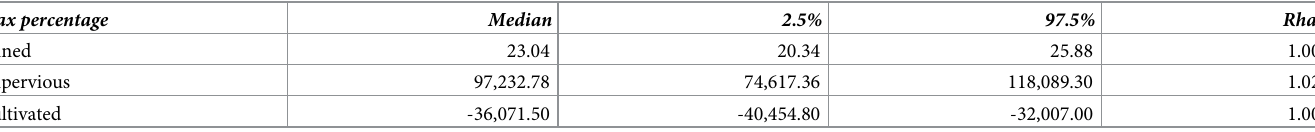
Cultivated Table shows the 50 th , 2.5 th , and 97.5 th percentiles of posterior distributions of regression coefficients quantifying the relationship between and probability of impairment, as estimated by logistic regression models with random effects. Measures of MCMC chain convergence (Rhat) are included.